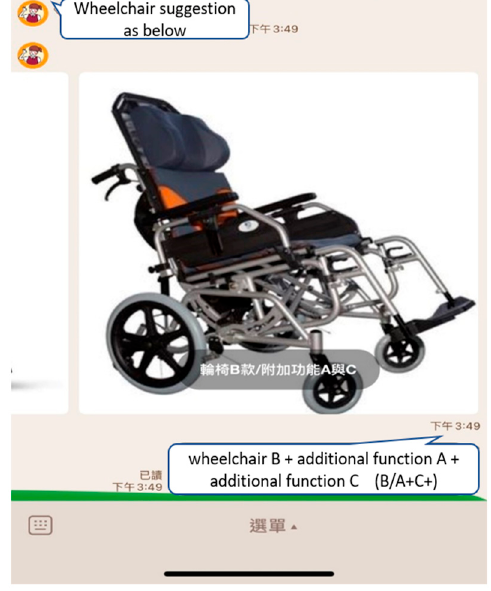
Figure 6. Assistive devices helper (LINE BOT)—Wheelchair type suggestion.